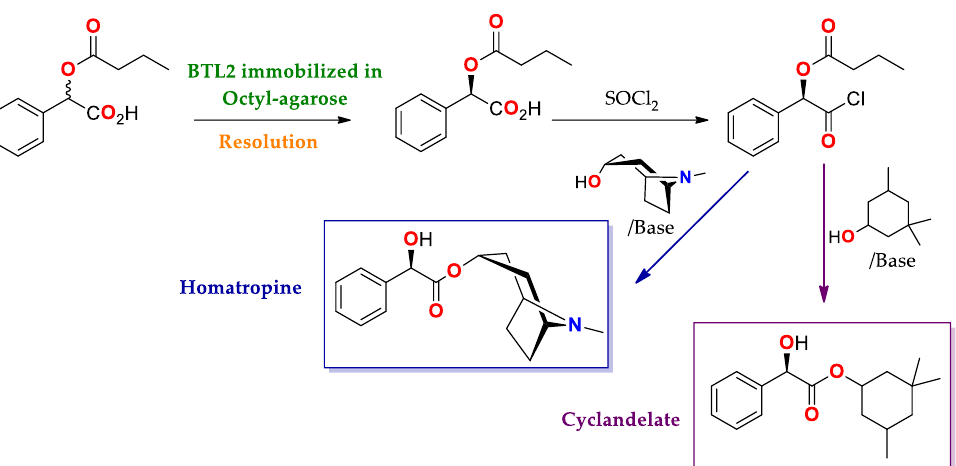
Scheme 8. Proposed synthetic route using the resolution capacity of BTL2 for the production of the derivatives of mandelic acid